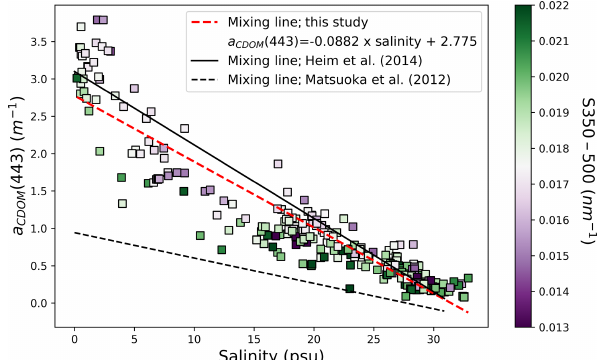
Figure 3. Relationship between a CDOM (443) and salinity ( n = 283, r 2 = 0 . 87) for all available water sampled from less than 10m water depth and a salinity > 0 . 2; colour of data points indicates S350– 500; red dashed line shows the linear fit representing the mixing line between salinity and a CDOM (443) within this dataset. The solid black line shows the reported mixing line from Heim et al. (2014) and the dashed black line shows the one from Matsuoka et al. (2012) (adapted to a CDOM (443) using Eq. 2 and a constant slope of